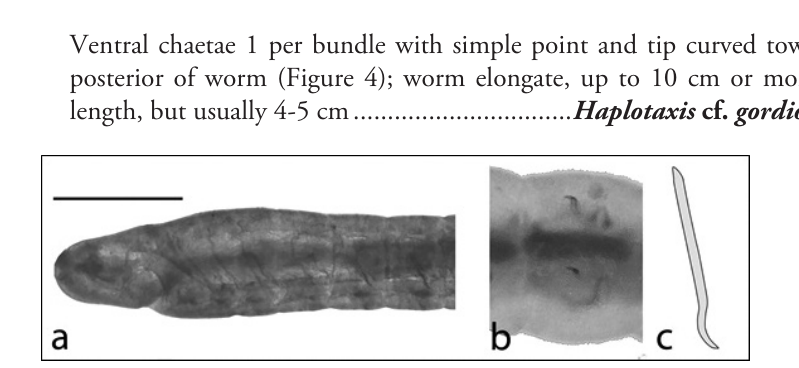
Figure 4. Haplotaxis cf. gordioides : A lateral view of anterior end showing prostomium and ventral mouth (scale 750 µm) B ventral view of one segment showing the two single ventral chaetae C drawing of one ventral chaeta.